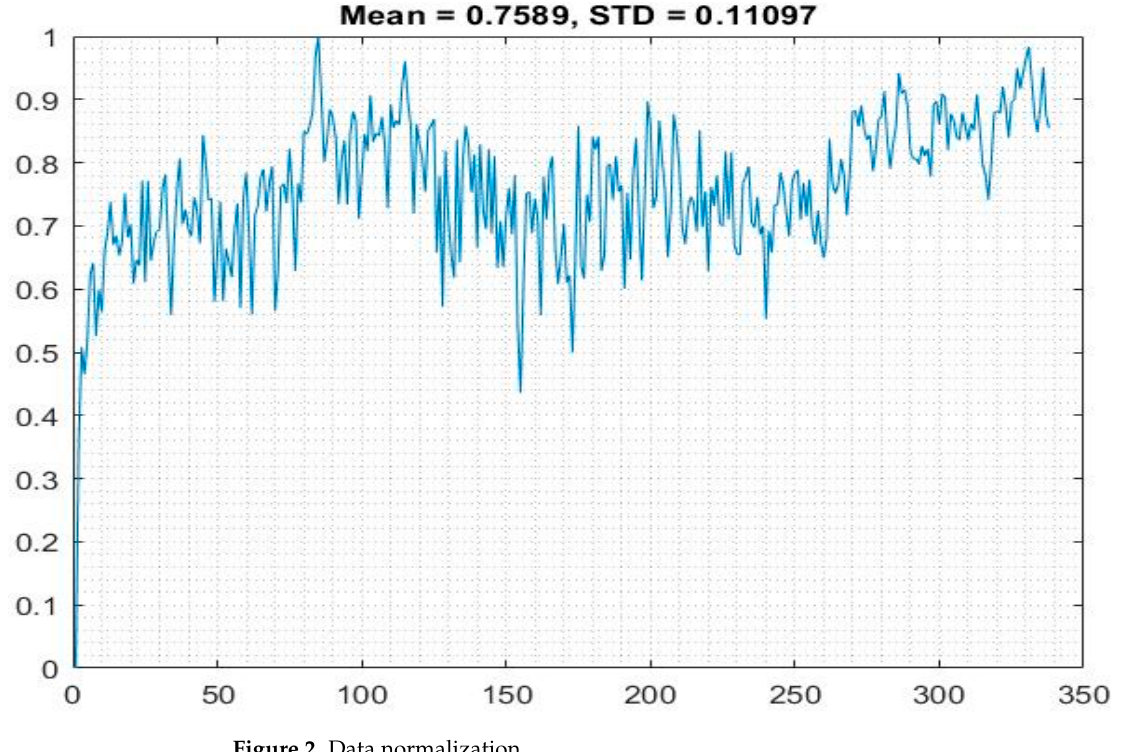
Figure 2. Data Figure 2. Data normalization.